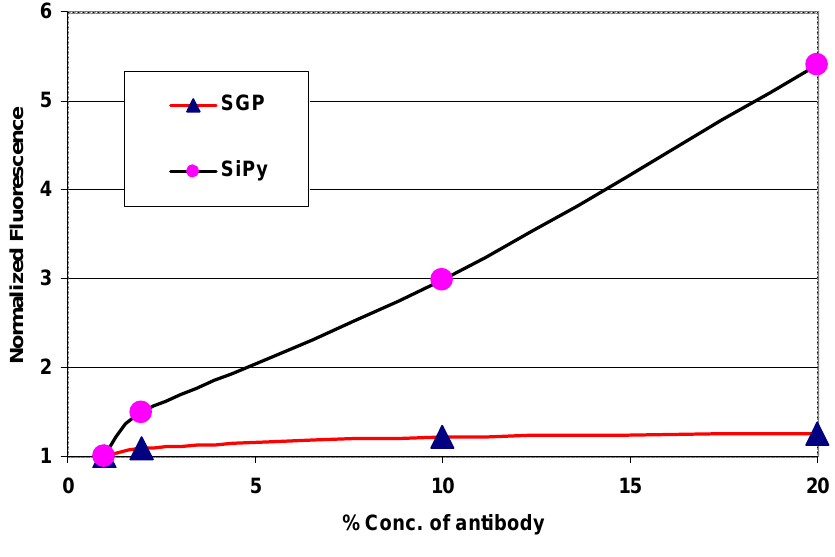
Figure 10: Comparison of the remnant fluorescence on SiPy and SGP after rinsing the microfluidic channels with IPA for the different concentration of antibody at 670 nm emission